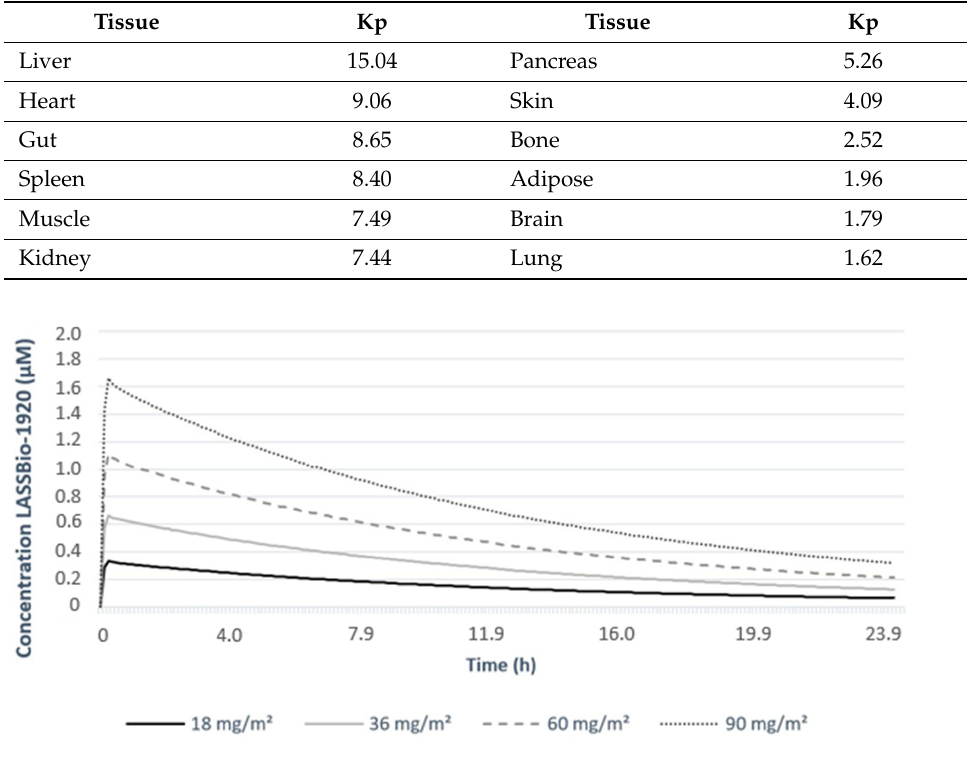
Figure 6. LASSBio–1920 concentration-time profiles in human simulation Figure 6. LASSBio – 1920 concentration-time profiles in human simulation module.